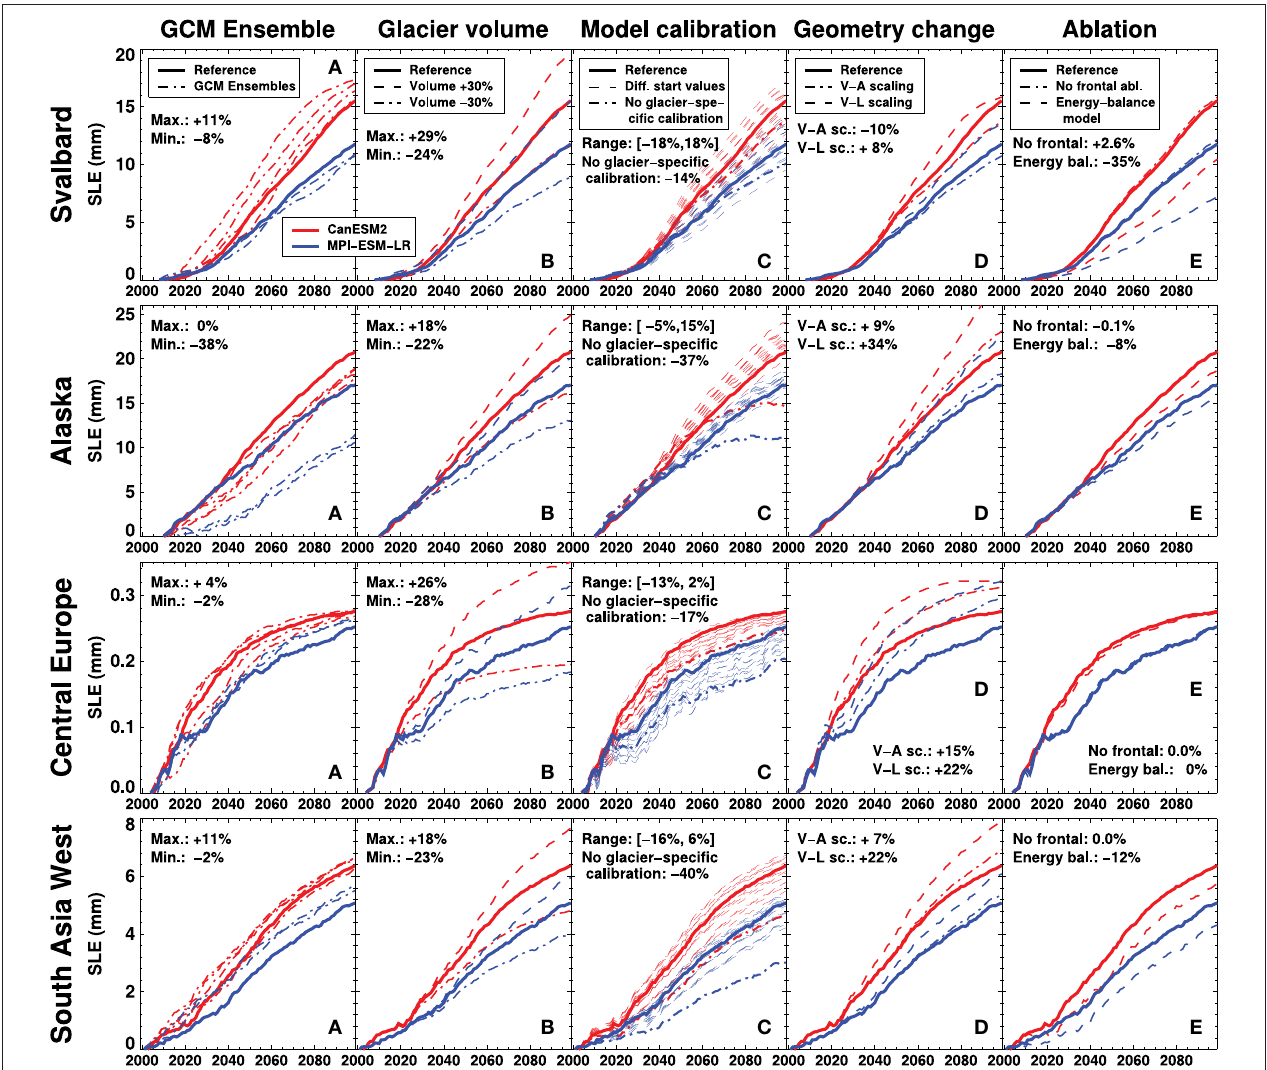
FIGURE 12 | Uncertainty assessment of modeled sea-level equivalent (SLE 1 M ) for Svalbard, Alaska, Central Europe and South Asia West using two GCMs (CanESM2, MPI-ESM-LR) forced by RCP4.5. Sensitivity of SLE to (A) the choice of the GCM ensemble member, (B) variations in initial glacier volume, (C) the technique used to calibrate the model, (D) the approach to calculate glacier geometry change, and (E) the model for frontal ablation and snow/ice melt. Percentages refer to differences between sensitivity experiments and reference